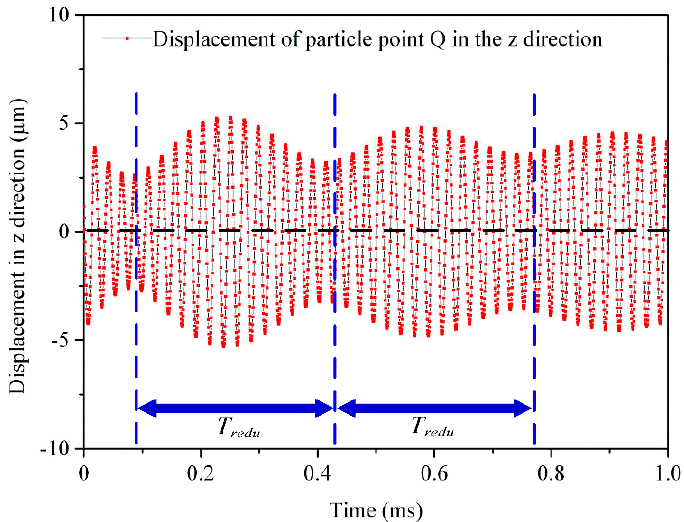
Figure 10. Displacement variation curve of the vertical direction.